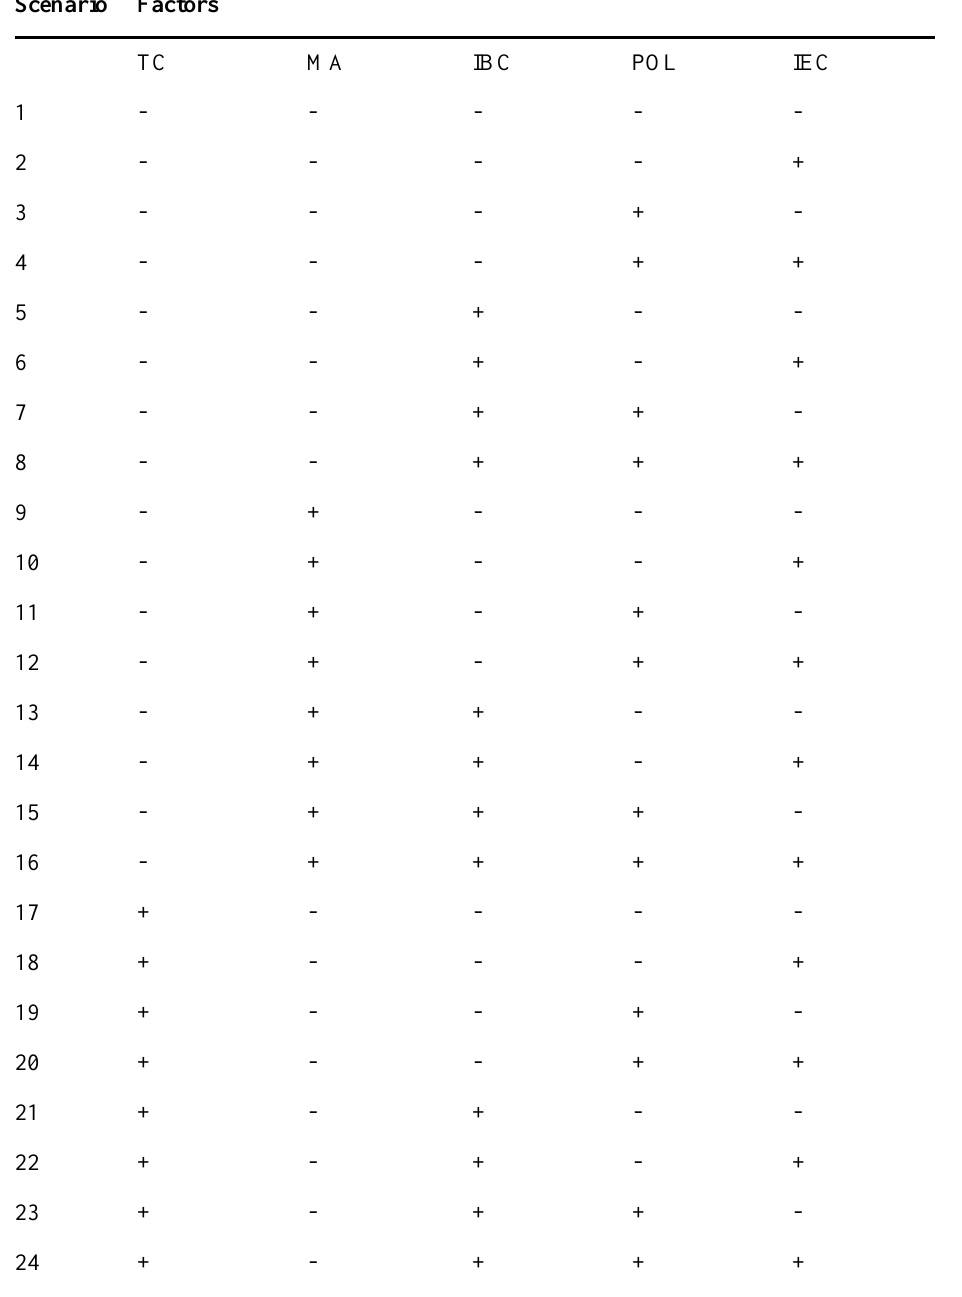
Table 6. Full factorial design matrix for 25 possible factor combinations: (-) denotes low factor level, (+) denotes high factor levels. IBC stands for interest on borrowed capital, IEC stands for interest on equity capital, MA stands for cost savings due to managerial ability, POL stands for the policy scenario, and TC stands for technological